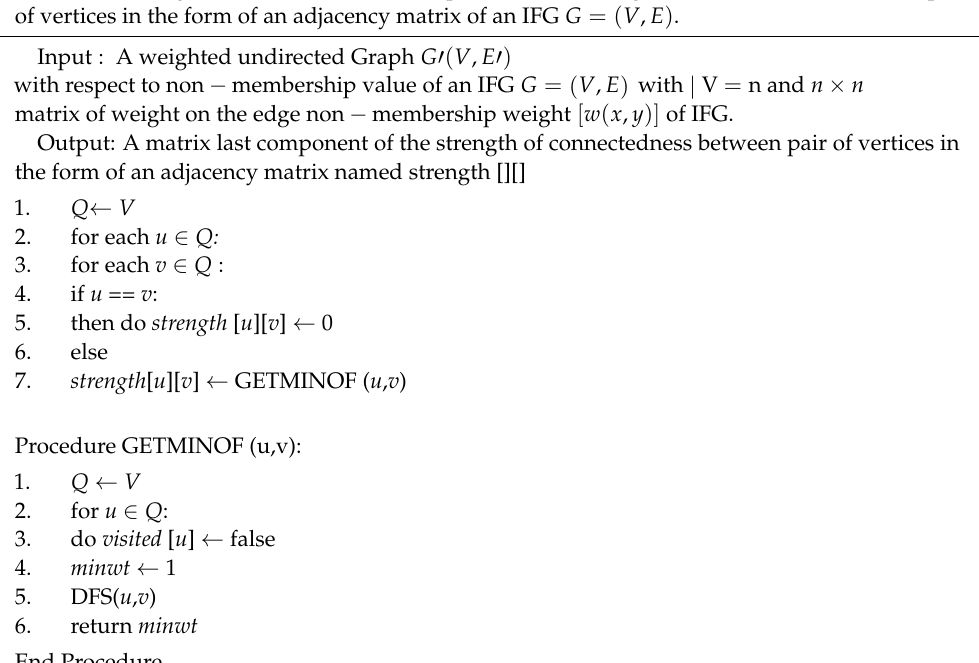
Algorithm 2: Algorithm to find the last component of the strength of connectedness between pair of vertices in the form of an adjacency matrix of an IFG G = ( V , E )